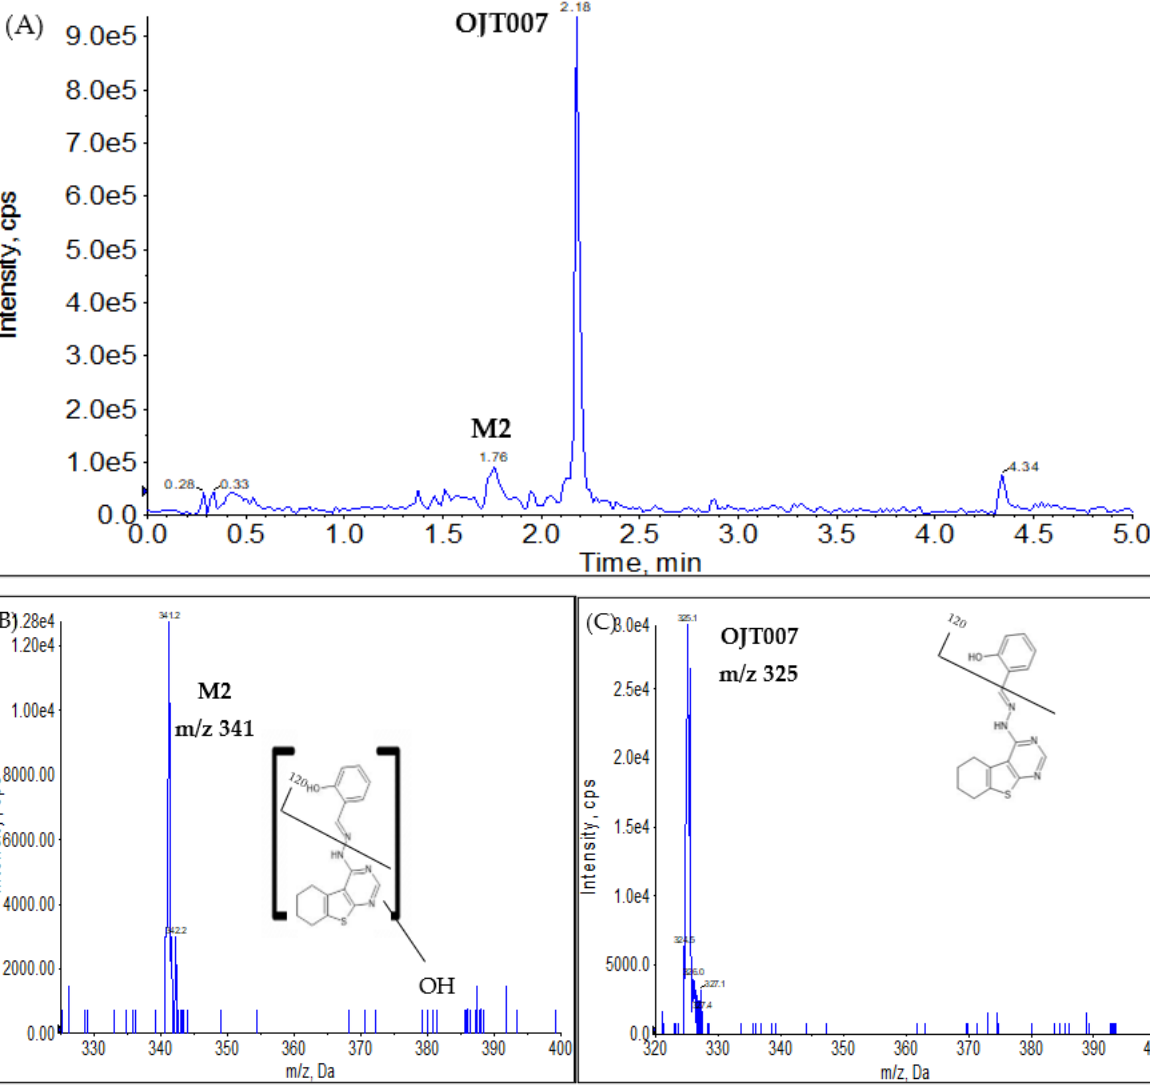
Figure 4. ( A ) Neutral loss (NL) of 120 Da Chromatogram ( B ) Spectra for M2 (retention time: 1.76 min) (M2). ( C ) Spectra for OJT007 (retention time: 2.18 min).